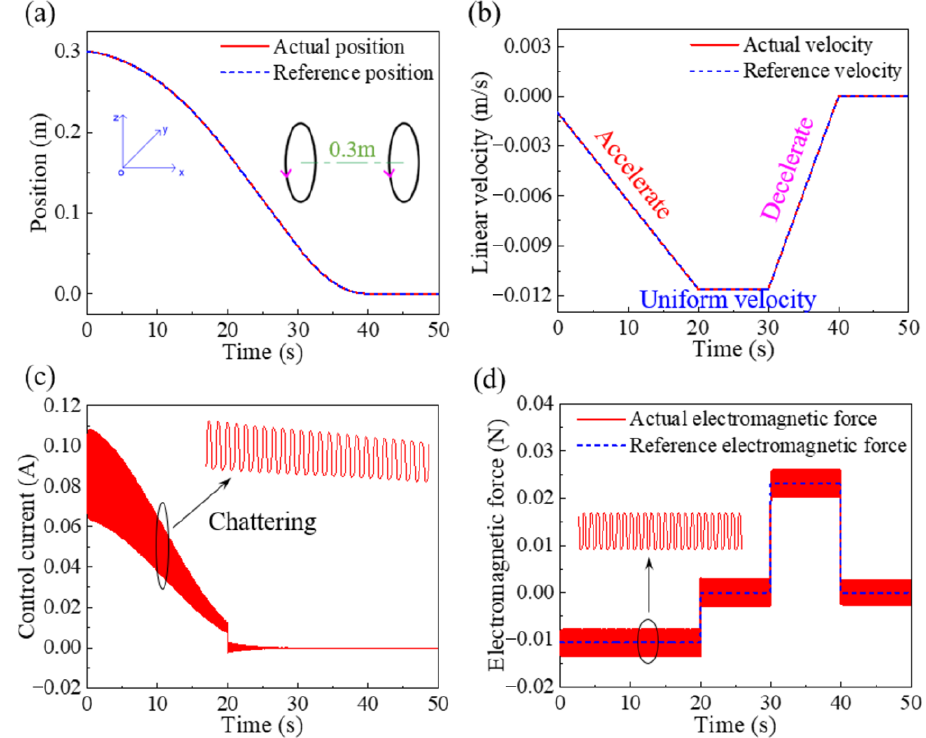
Figure 9. The position ( a ), linear velocity ( b ), control current ( c ), and electromagnetic force ( d ) of the sliding mode control based on exponential reaching law with the non-interfering condition.